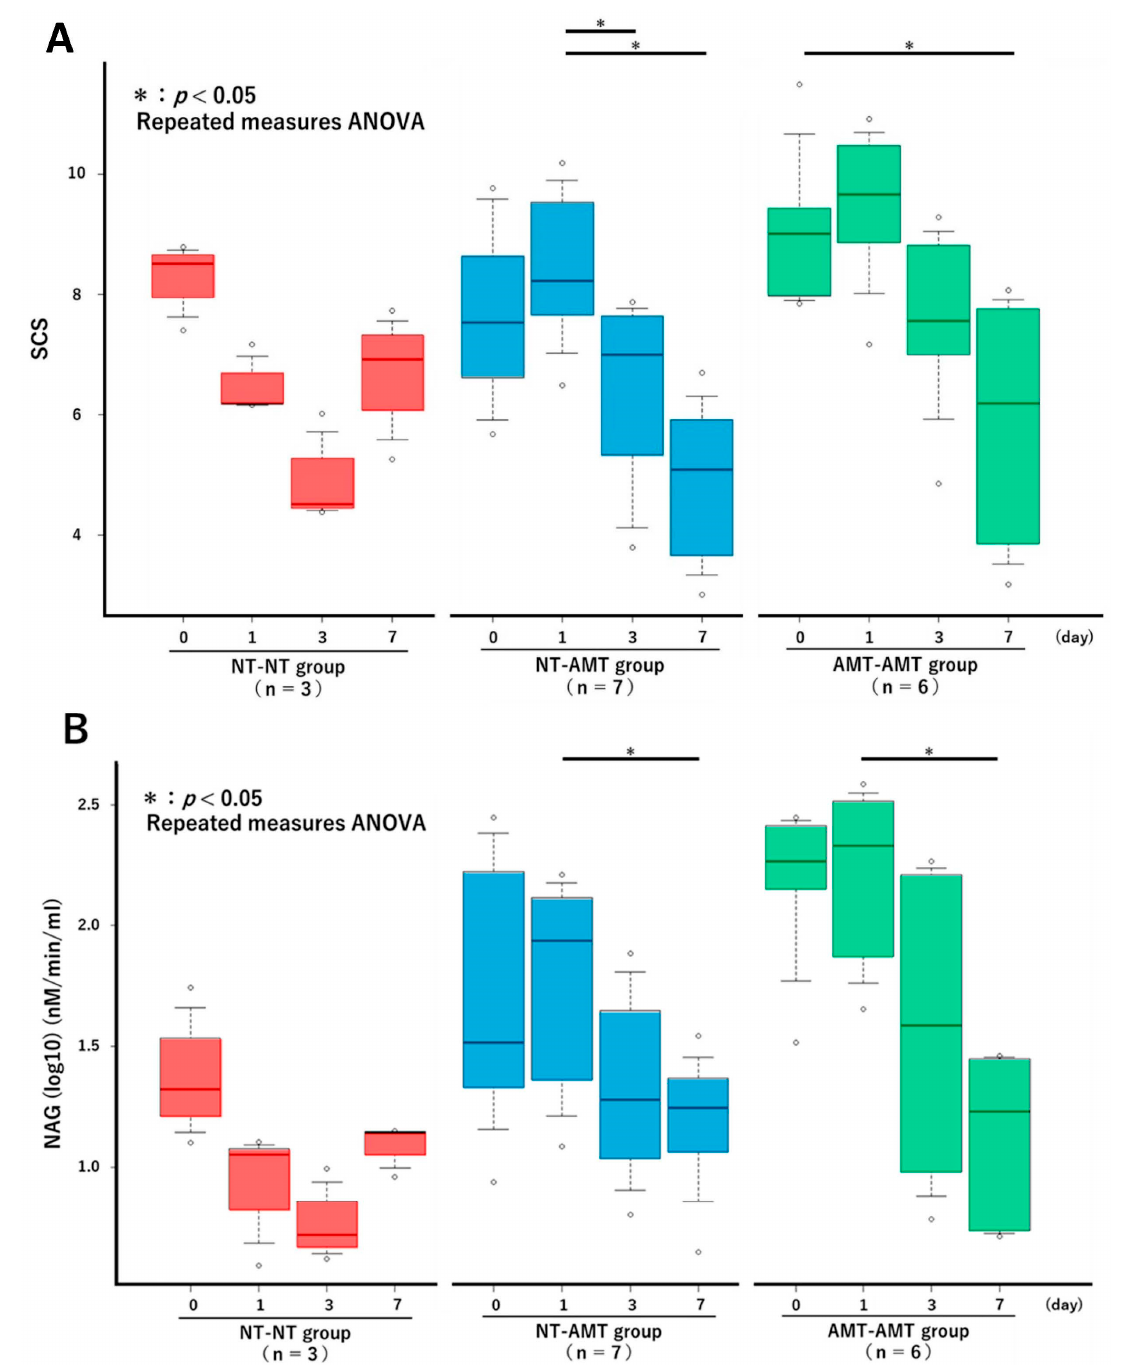
Figure 1. The changes in the Somatic Cell Score ( A ) and NAGase activity ( B ) over time (day 0, 1, 3, 7) in each treatment group (NT-NT, NT-AMT, AMT-AMT) for mastitis with Gram-positive bacteria. Bars represent standard deviation of the mean. Asterisks represent significant differences from the results of the repeated measures ANOVA among the days within the same group. ( A ) The changes in the SCS over time in each treatment group. There were no significant changes in the NT-NT group, but there were significant reductions between days 1 and 3, and days 1 and 7 in the NT-AMT group, and between days 0 and 7 in the AMT-AMT group. ( B ) The changes in the NAGase activity over time in each treatment group. There were no significant changes in the NT-NT group, but there were significant reductions between days 1 and 7 in the NT-AMT and AMT-AMT groups.